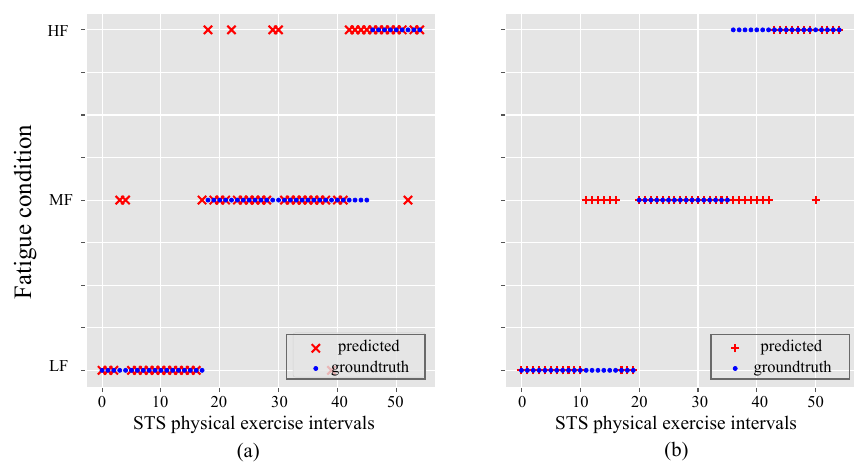
Figure 18. Gender comparison of STS physical exercise intervals versus fatigue condition on the test set. Crosses and × symbols describe the ground-truth values, and the thickest dots present; ( a ) represents the fatigue condition in STS physical exercise intervals in male patients and ( b ) represents the fatigue condition in STS physical exercise intervals in female